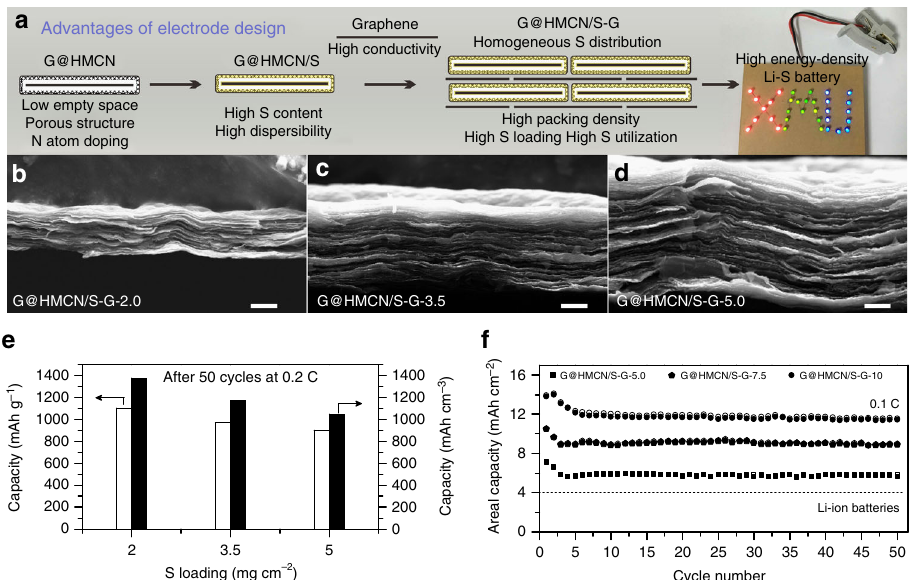
Fig. 5 The volumetric and areal capacities of G@HMCN/S-G. a Schematic illustration for the advantages of electrode design; b – d the cross-section SEM images of G@HMCN/S-G-2.0, G@HMCN/S-G-3.5, and G@HMCN/S-G-5.0; e the volumetric capacities of G@HMCN/S-G-2.0, G@HMCN/S-G-3.5, and G@HMCN/S-G-5.0 after 50 cycles at 0.2 C, f the areal capacities of G@HMCN/S-G-5.0, G@HMCN/S-G-7.5, and G@HMCN/S-G-10 at 0.1 C. The solid and hollow symbols in f represent the discharge and charge capacities, respectively. Scale bars, 10 μ m b – Fig. 19. The charge/discharge pro fi les from 0.1 to 4 C clearly evaluated at a high rate of 1 C. As shown in Fig. 4j and Supplementary Fig. 21, G@HMCN/S-G-5.0 delivered an initial − 1 after activation at 0.1 C for one cycle. capacity of 900 mAh g